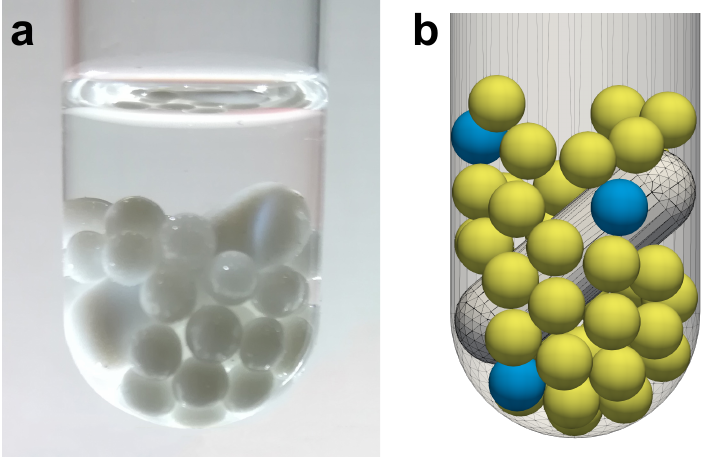
Figure 1. ( a ) Detail of the experimental setup. ( b ) Snapshot of the bottom portion of the simulation domain, with stirring bar and the beads (yellow for ZrO 2 and light blue for Ag), partially lifted by the bar